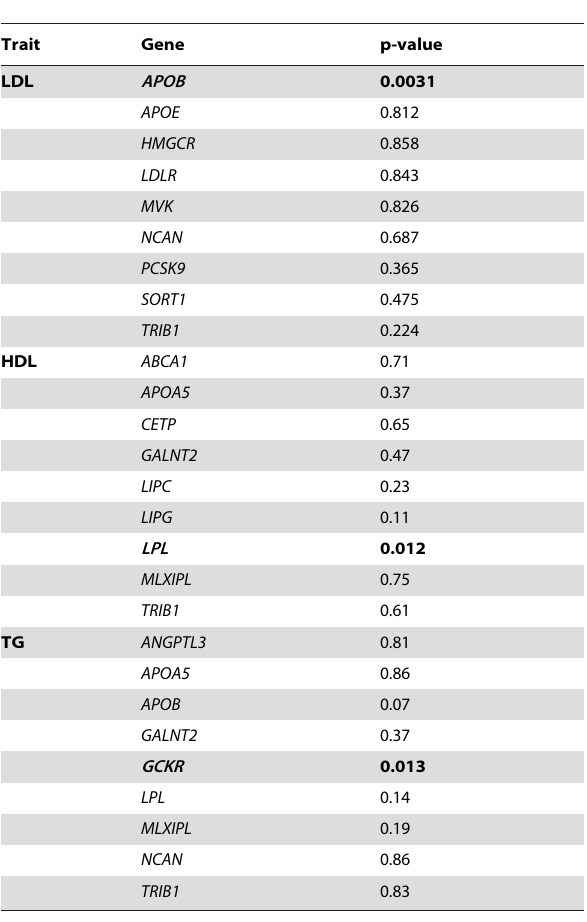
Local ancestry values were estimated using ANCESTRYMAP and the strength of the association of local ancestry with each trait was evaluated by linear regression as in Table 2. Associations significant at the p , 0.05 level are shown in